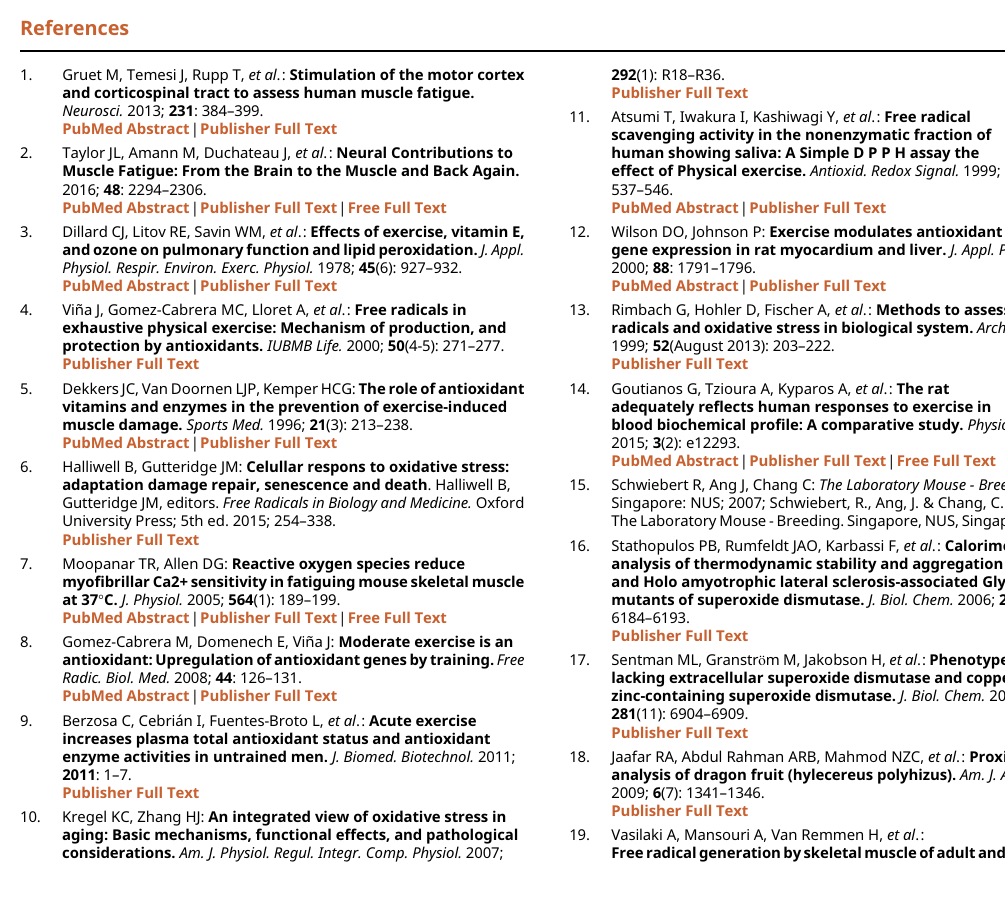
Figshare: ARRIVE checklist for ‘ The effect of ingestion of Red dragon fruit extract on levels of malondialdehyde and superoxide dismutase after strenuous exercise in rats ( Rattus norvegicus ) ’ , https://doi.org/10.6084/m9.figshare. 15074544.v5.